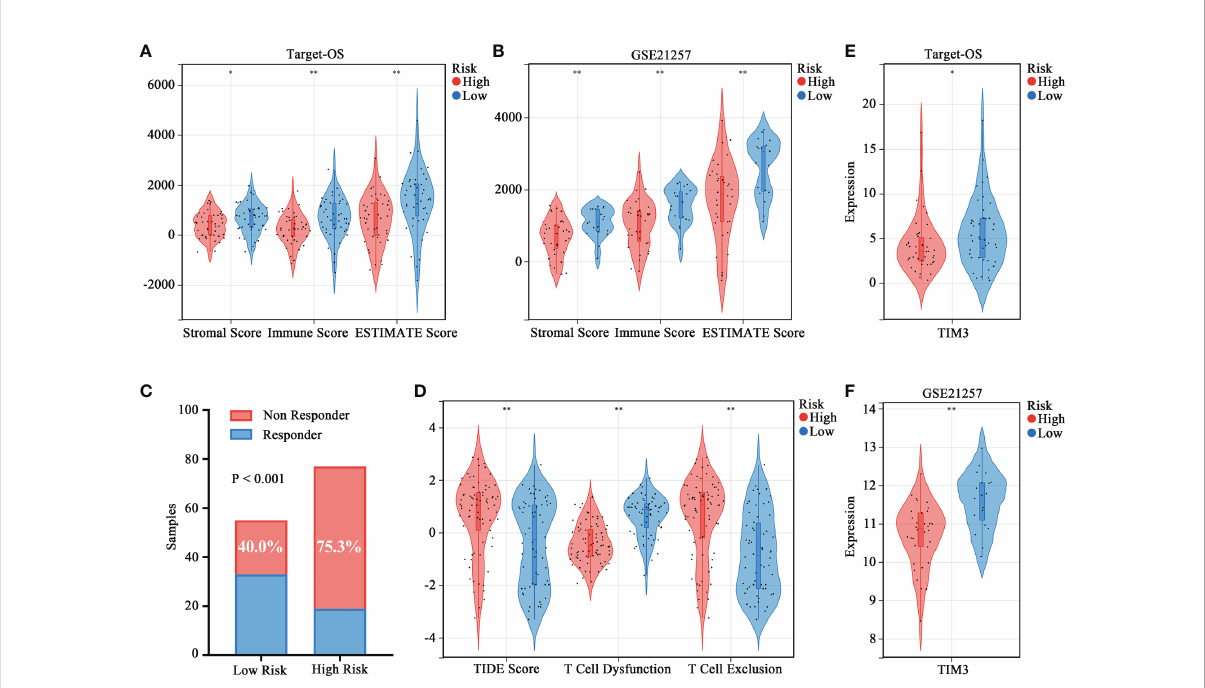
FIGURE 5 Association between the HBP-related prognostic risk model and immune microenvironment along with immunotherapy prospects. (A, B) Stromal, immune and ESTIMATE scores calculated by ESTIMATE algorithm between the high- and low-risk groups. (C) Distributions of responders and non- responders predicted by TIDE immunotherapy analyses in high and low risk groups among all patients in Target-OS and GSE21257 cohorts. (D) Distribution of TIDE scores in high- versus low-risk group. (E, F) Violin plots visualizing signi fi cantly different immune checkpoint (TIM3) between high- and low-risk patients. “ * ” represents P<0.05 and “ ** ” represents